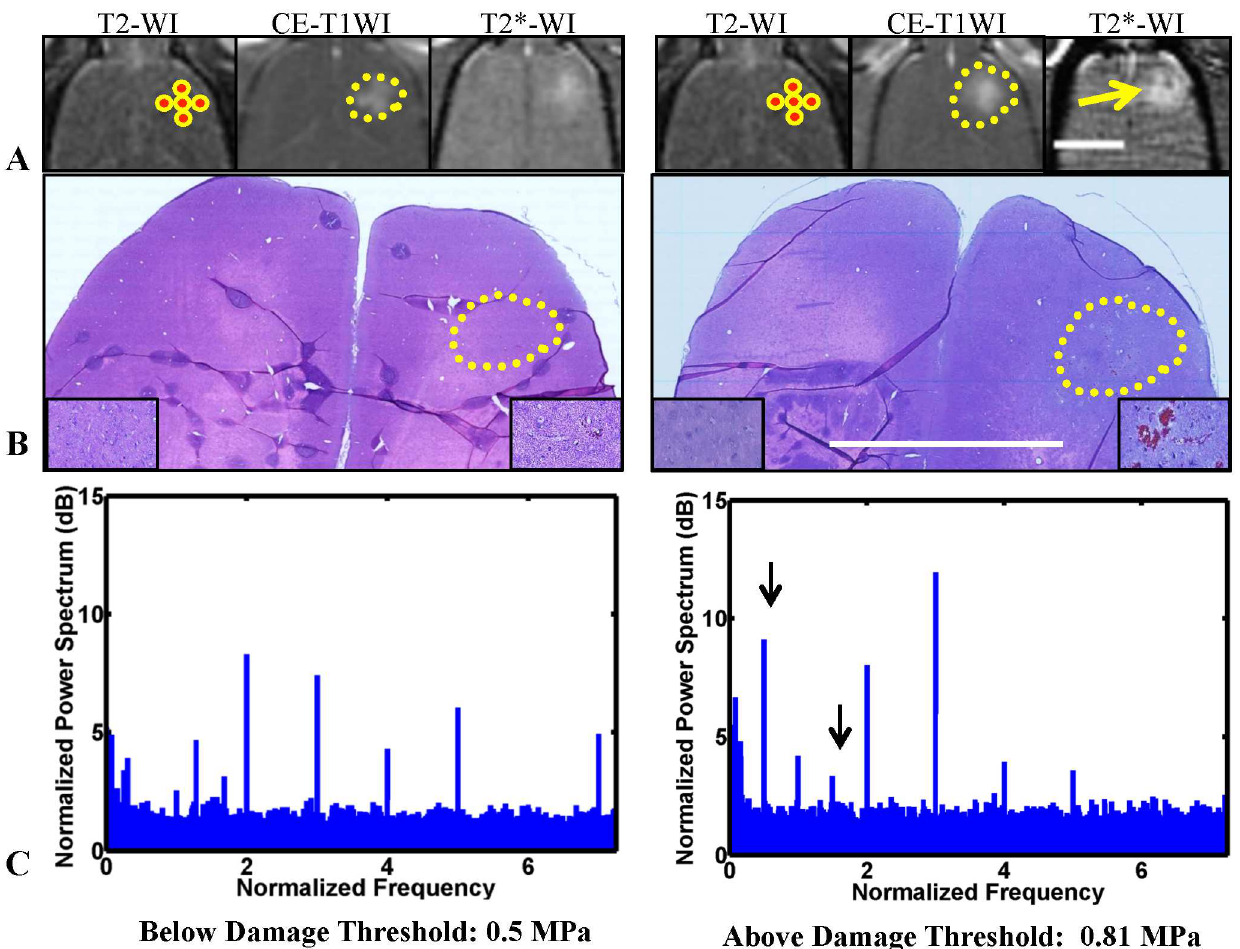
Fig 2. Sonication planning, monitoring, and assessmentof FUS-induced BBBD after microbubble-enhanced sonication at 0.55 (left) and 0.81 (right) MPa. A. Axial MRI acquiredduringFUS-BBBD. T2-weighted imaging(T2WI) was used for treatment planning,contrast- enhanced T1-weighted imaging(CE-T1WI) to verify BBB permeabilization, and T2 * -weighted imaging(T2 * WI) to detect tissue damage. The targeted spots are indicatedby circles; the yellow curves outline the extent of MRI contrast enhancement due to BBB permeabilization. Hypointense areas were evident in the focal plane at 0.81 MPa in T2 * WI (arrow), indicatingvessel damageand regions with extravasated erythrocytes; hyperintense areas in these images were due to MRI contrast agent extravasation. B. Appearance in H&E stainedsections after BBBD at 0.55 MPa (left, 24 hours) and at 0.81 MPa (right, one hour). At 0.55 MPa, most of the sonicatedregionappearedunaffected, but in a few areas with tiny clusters of extravasatederythrocyteswere seen (inset). Larger regions of erythrocyteswere evidentat 0.81 MPa. C. Examplesof acoustic emissionsrecordings. These power spectra were normalizedto recordings obtainedwithout microbubbles. In each case, strong harmonic emissions were observed. Ultraharmonic and subharmonic emissionwere observed occasionally